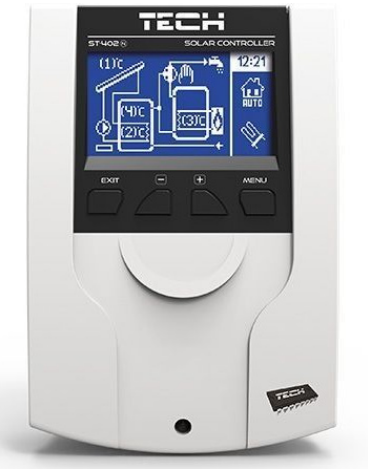
Figure 4. Tech ST-402n solar controller.